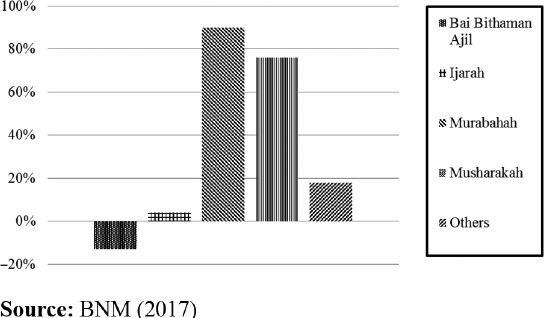
Figure 2. Changes in